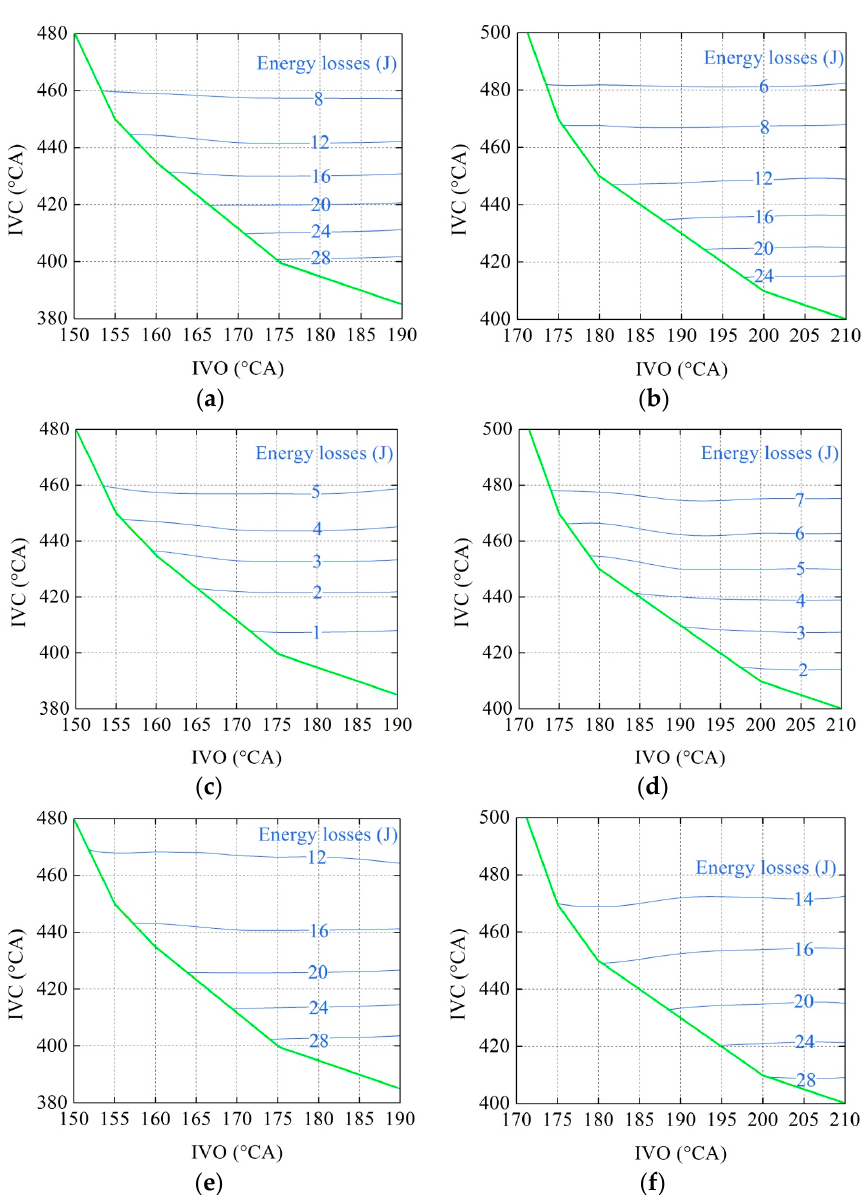
Figure 14. The energy losses of two periods: ( a ) Period I at 1200 rpm; ( b ) Period I at 1600 rpm; ( c ) Period II at 1200 rpm; ( d ) Period II at 1600 rpm; ( e ) Total energy losses at 1200 rpm; ( f ) Total energy losses at 1600 rpm.